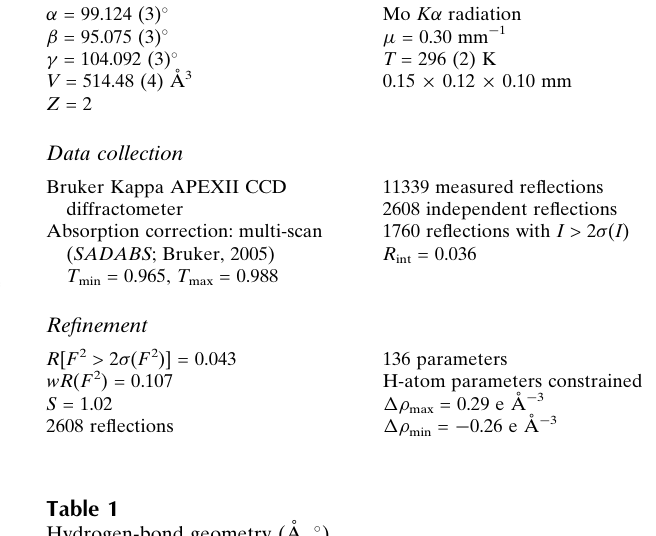
Hydrogen-bond geometry (A˚ , (cid:1)